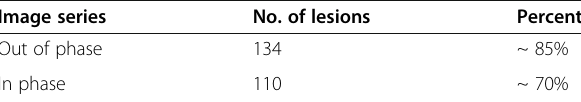
Table 5 Frequency of focal marrow abnormality detection by CSI ( n . of lesions = 157) Image series Out of